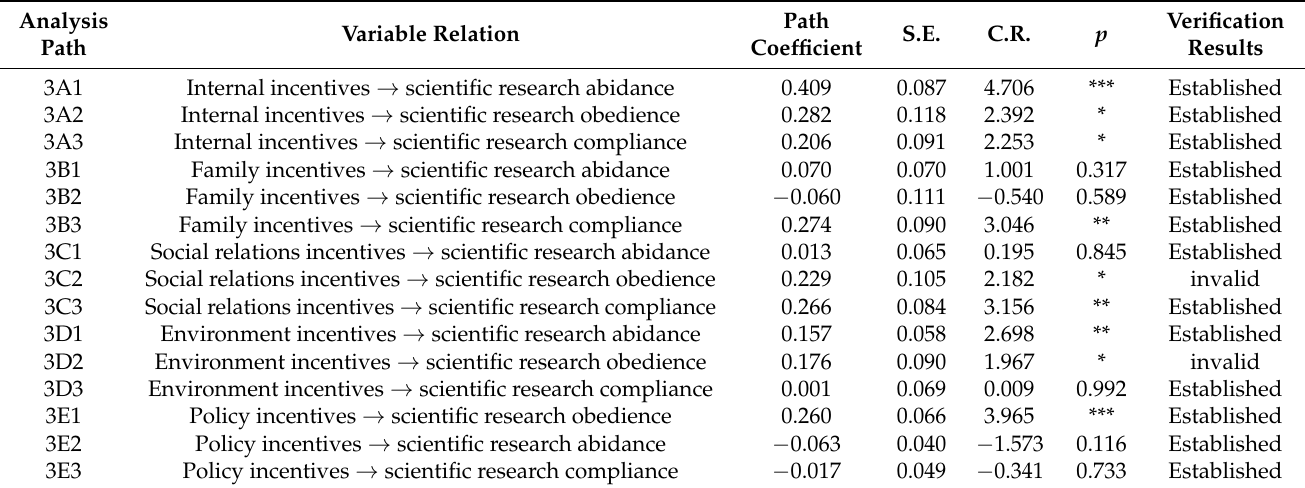
Table 8. Analysis of path